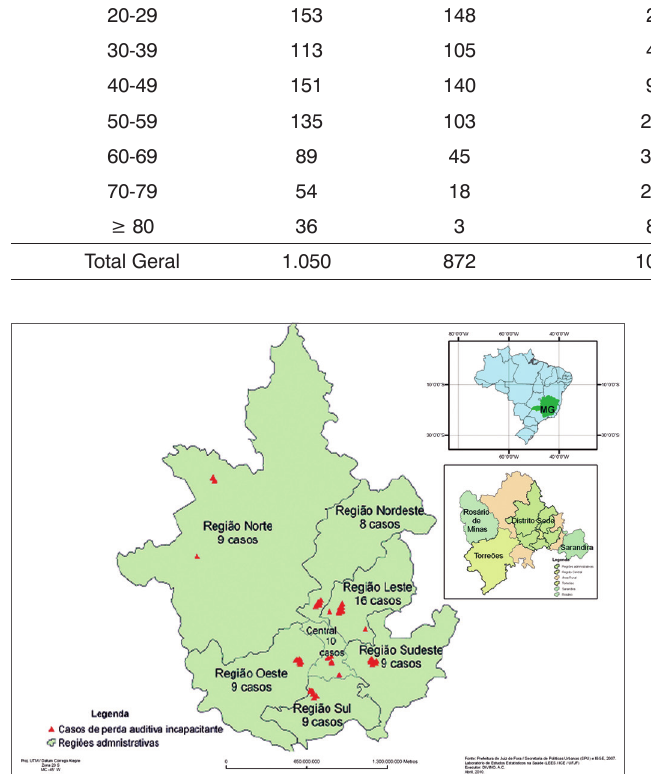
Figura 1. Distribuição dos indivíduos portadores de PAI entre os setores sorteados delimitados nas regiões administrativas correspondentes do município de Juiz de Fora, MG, Brasil, 2011 (n = 70). PAI: perda auditiva